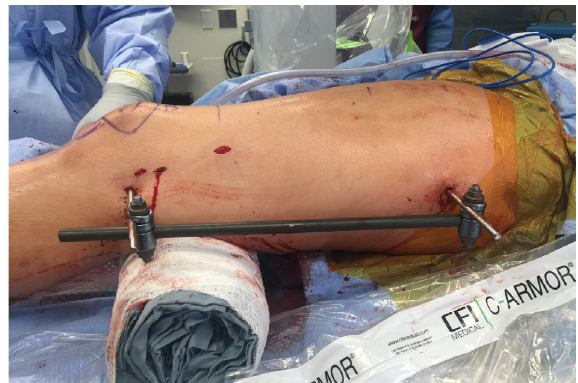
Figure 5. A simple pin-to-bar frame is used to hold the reduction of the